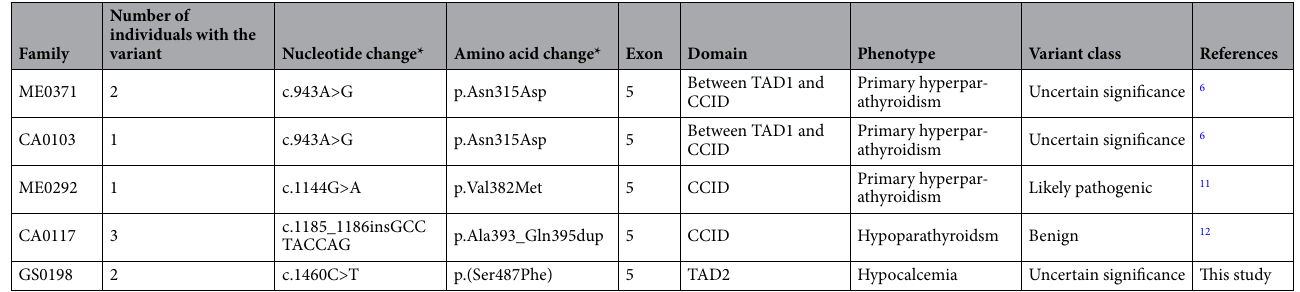
Table 1. GCM2 variants identified in patients. *Numbering is according to DNA sequence (Ensembl: ENST00000379491.5), all in heterozygous. TAD1 transcriptional activation domain 1, TAD2 transcriptional activation domain 2, CCID C-terminal conserved inhibitory domain.